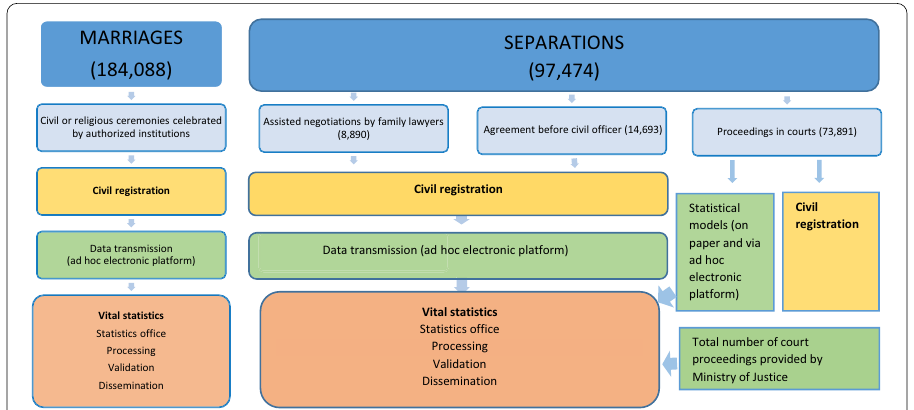
Fig. 2 Italian civil registration and vital statistics system since 2015: focus on marriages and separations (2019